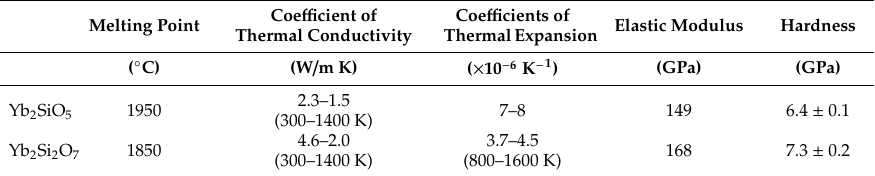
Table 1. Thermal-mechanical properties of bulk Ytterbium silicate materials. Melting